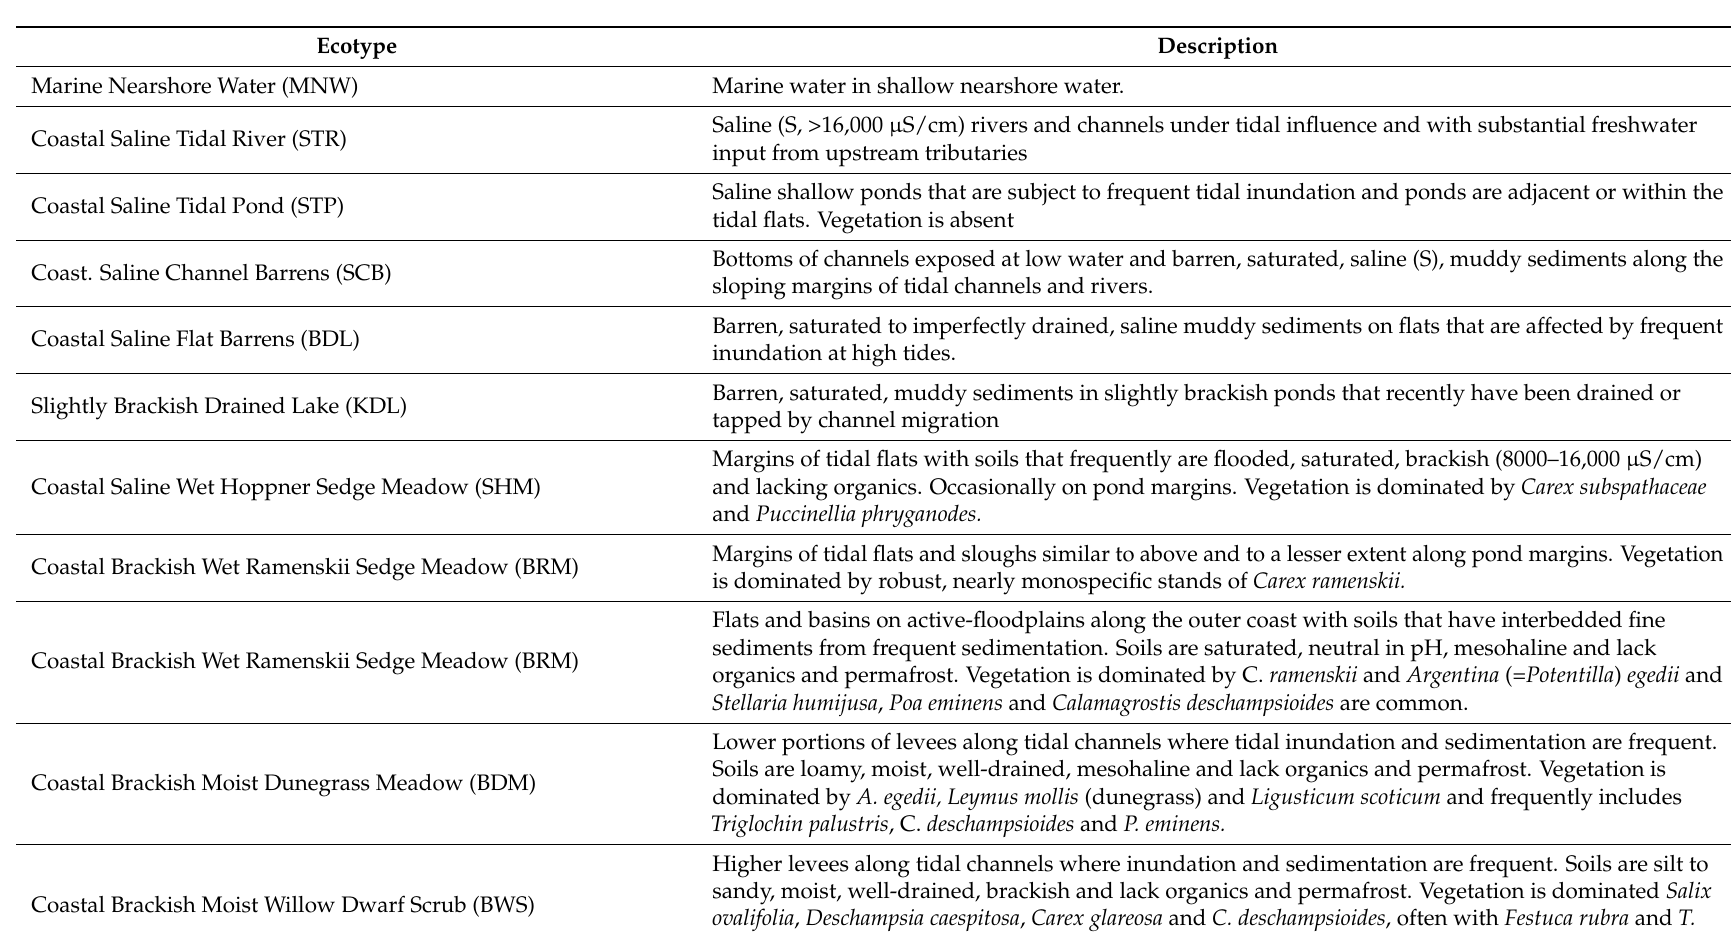
Table A2. Classification and description of ecosystem types on the Yukon-Kuskokwim